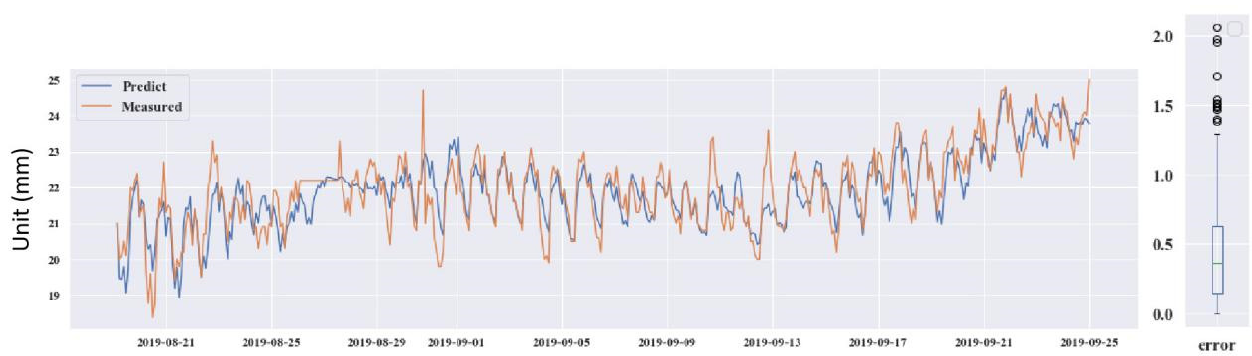
Figure 15. Predicted and measured planar displacement of GPS 12.